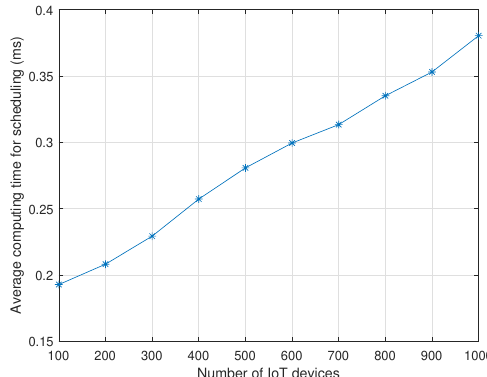
Figure 8. Computation time (ms) vs. number of IoT